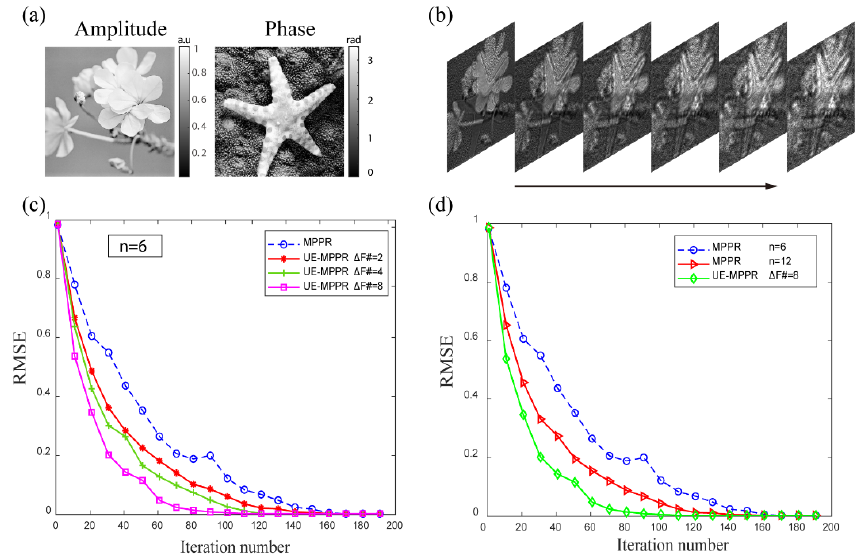
Figure 2. Simulations comparing phase retrieval methods. ( a ) Amplitude and phase of the simulated ground truth complex field. ( b ) The stack of propagation intensity images. ( c ) The RMSE plots of the MPPR and UE-MPPR methods with different interval spaces. ( d ) The RMSE plots of MPPR using 6 and 12 diffraction planes, and UE-MPPR using 5 diffraction planes with interval space of the adjacent planes ∆ F # =